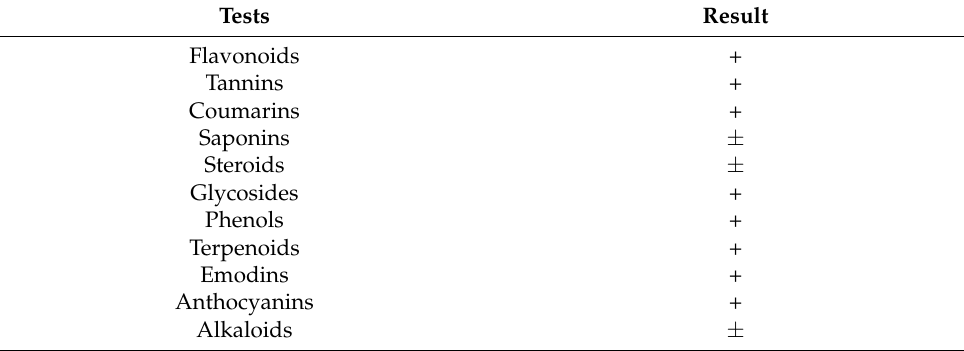
Table 1. Phytochemical screening of ERF of M. arboreus